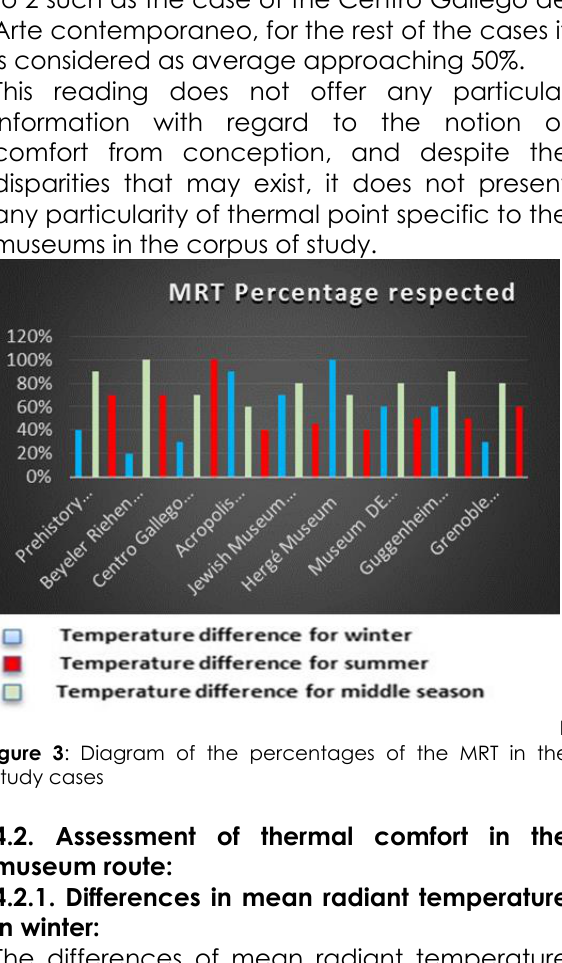
igure 3 : Diagram of the percentages of the MRT in the